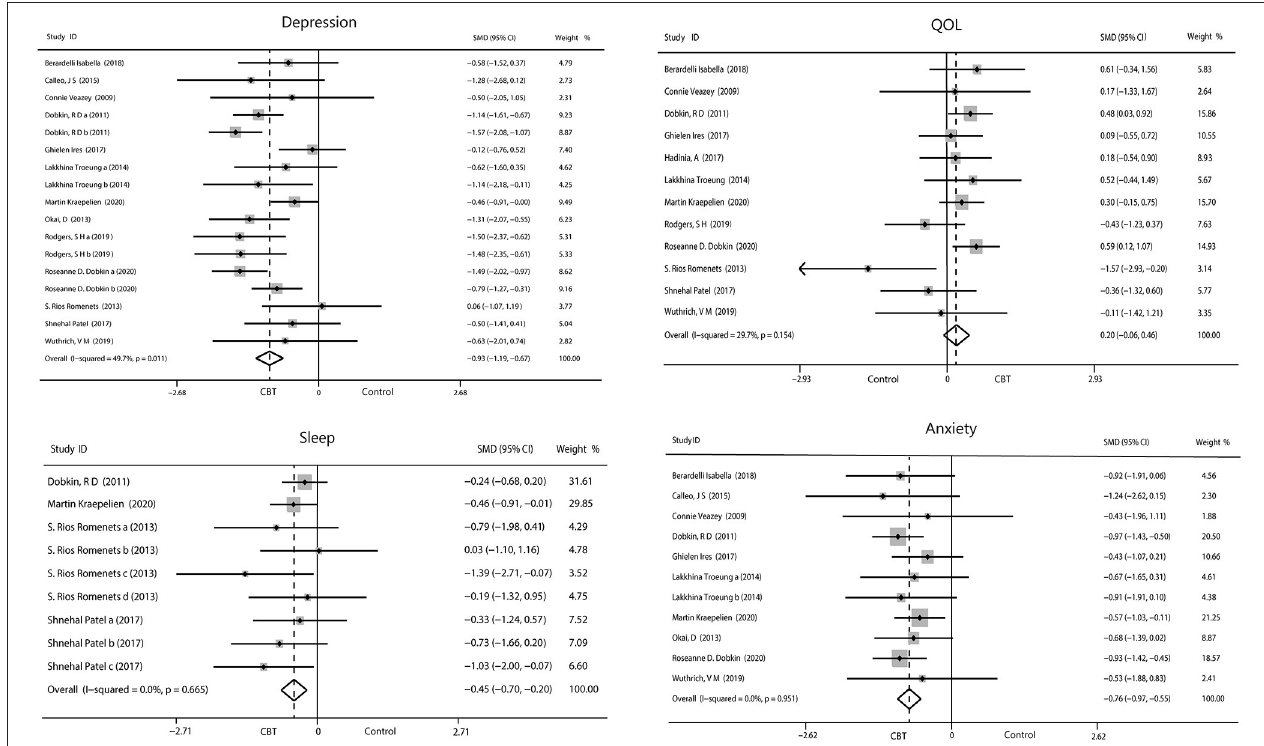
FIGURE 3 | Forest plot of random effects model meta-analysis of the effect of CBT on depression, anxiety, sleep, and QOL. CBT, cognitive behavioral therapy; QOL, quality of life.